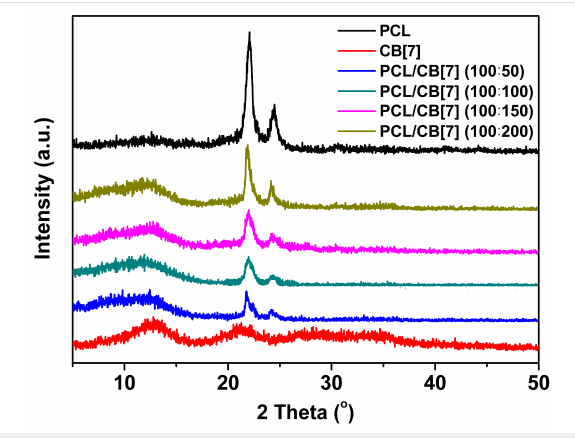
Figure 2: XRD curves of PCL, CB[7] and the PCL/CB[7] nanofibers.